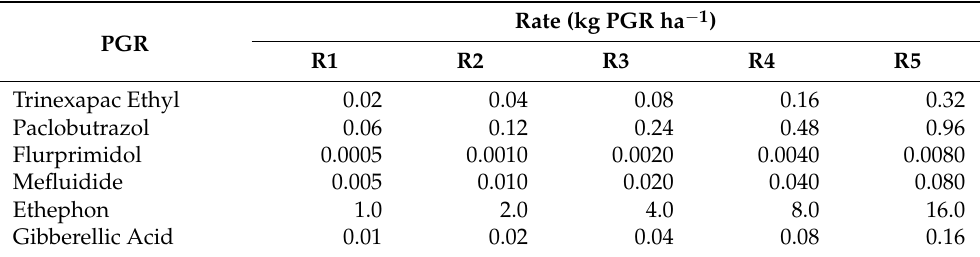
Table 1. PGR rates applied during the